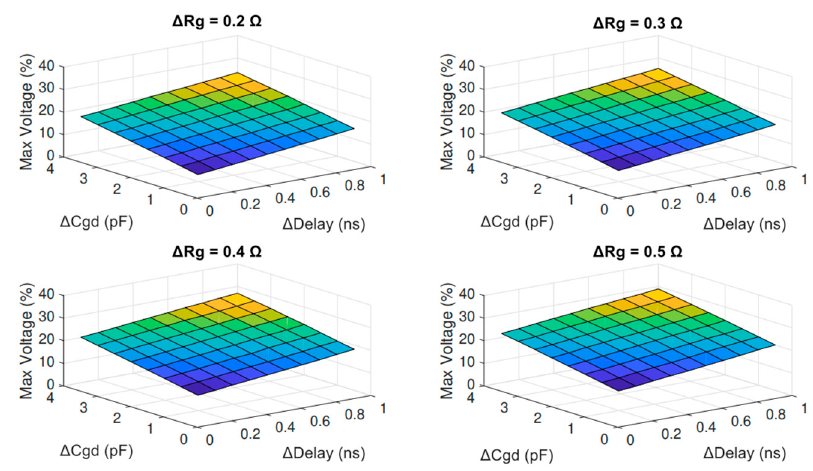
Figure 13. Sensitive analysis results as a function of ∆ R g , ∆ C gd , and ∆ delay .